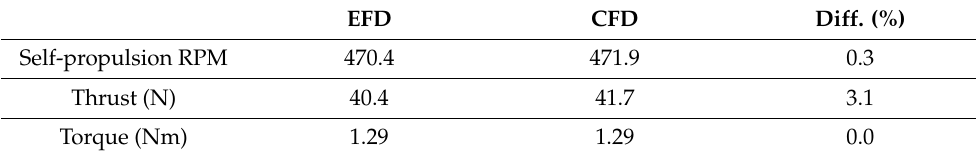
Table 5. Comparison of self-propulsion analysis results between EFD and CFD.